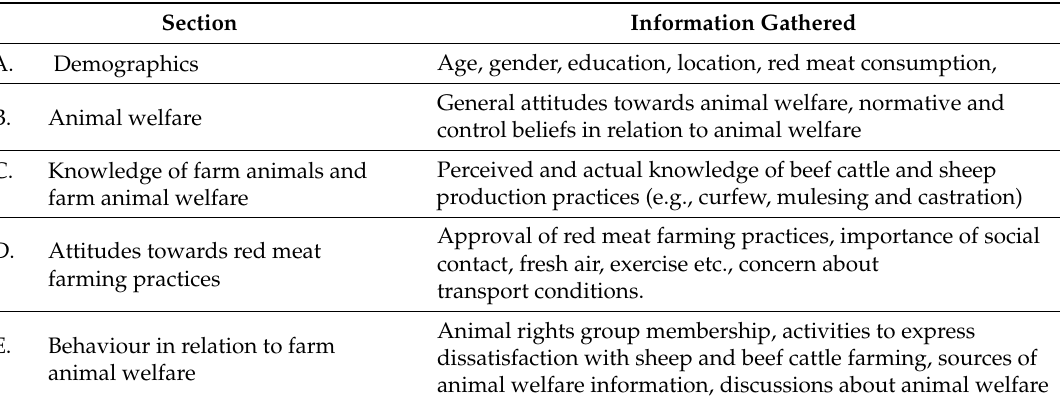
Table 1. Structure of the